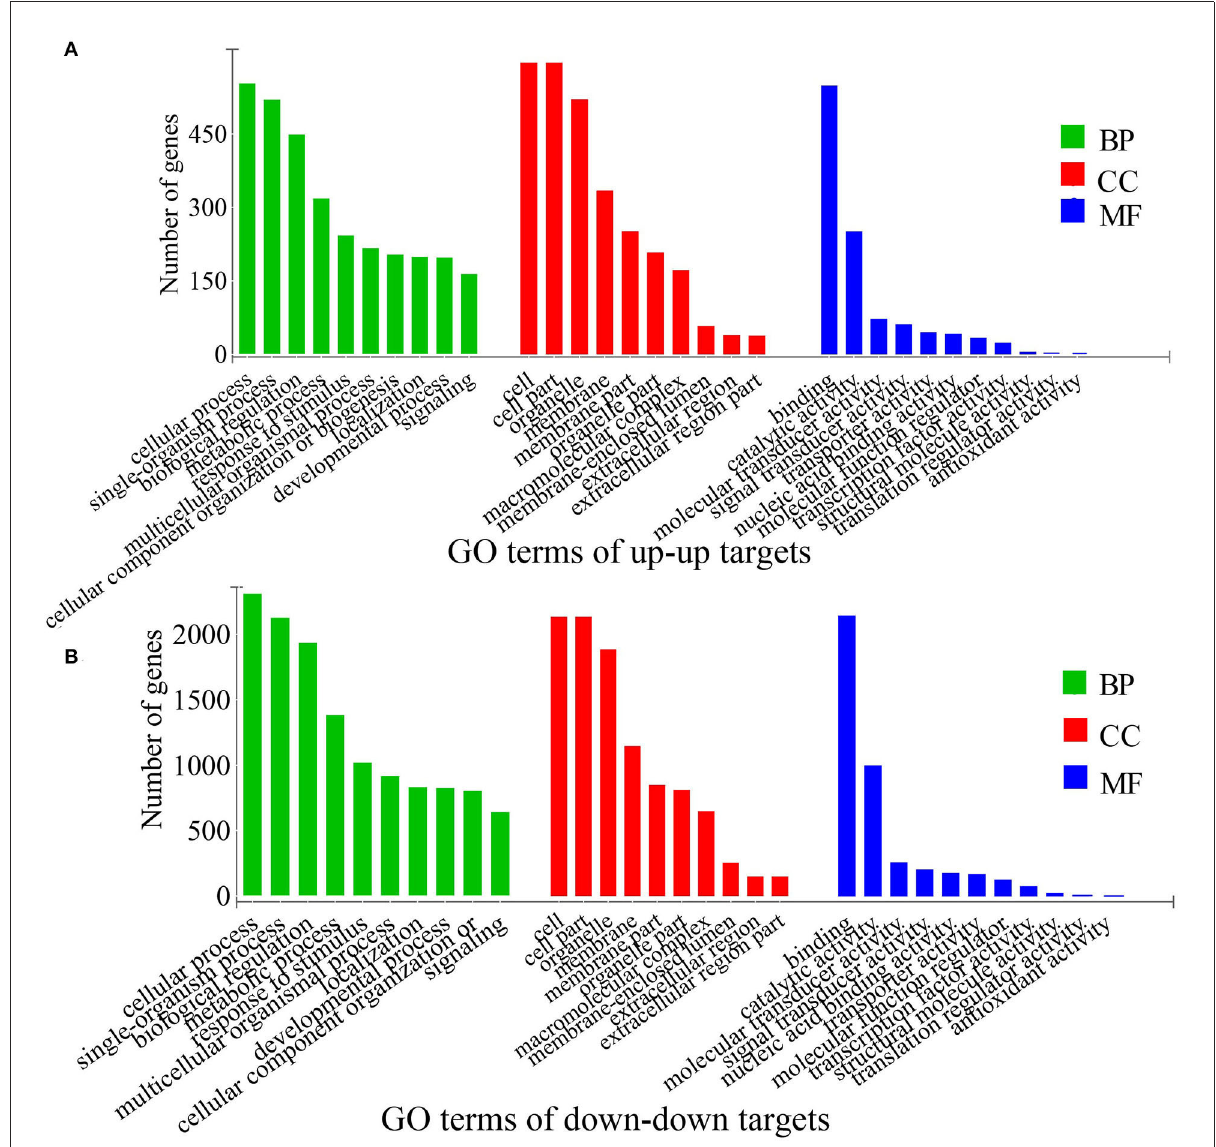
FIGURE6 Top 10 GO enrichment of the differentially expressed target mRNAs in LP vs. FP. (A) Top 10 GO terms of up-up regulated targets, (B) top 10 GO terms of down-down regulated